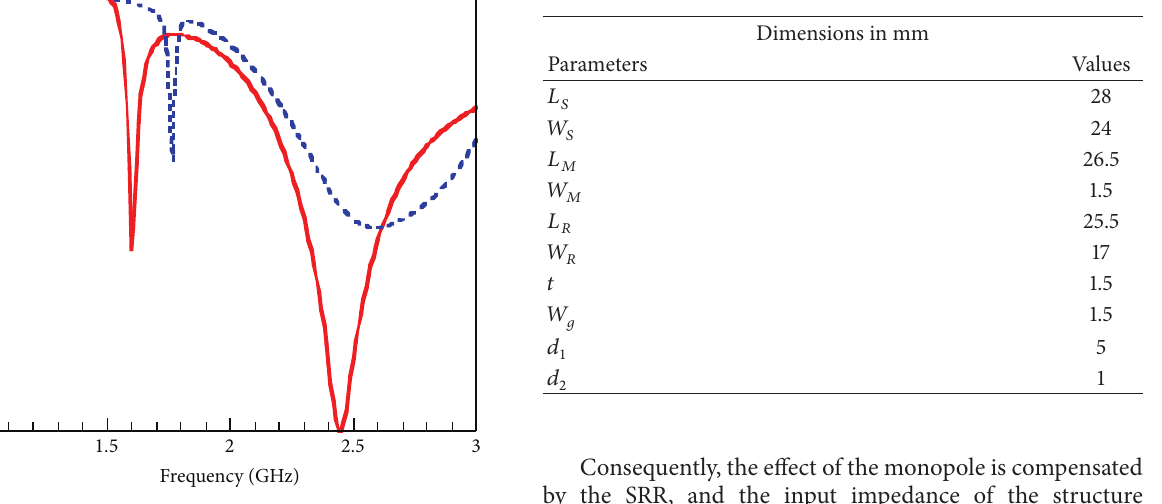
Table 1: Parameters